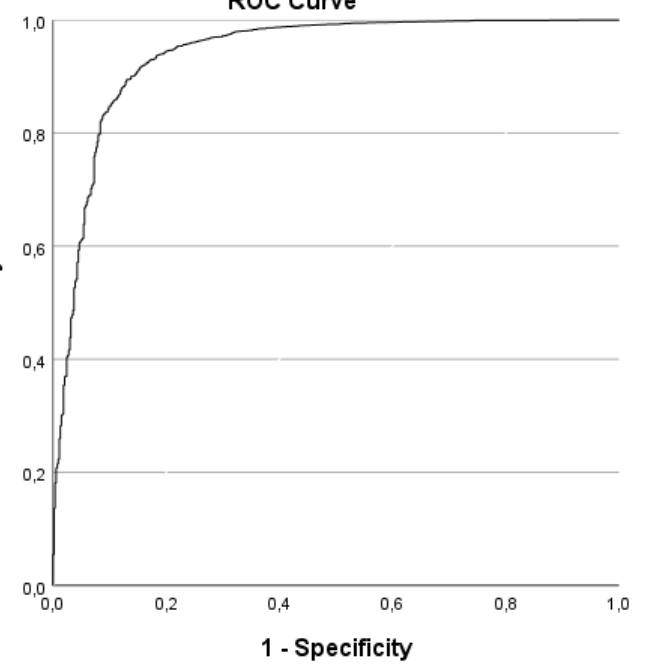
Figure 1. The receiver operating characteristics (ROC) curve with predicted probabilities for the multivariate logistic regression analysis for students’ COVID-19 vaccination status in summer/fall 2021 (n = 6379).